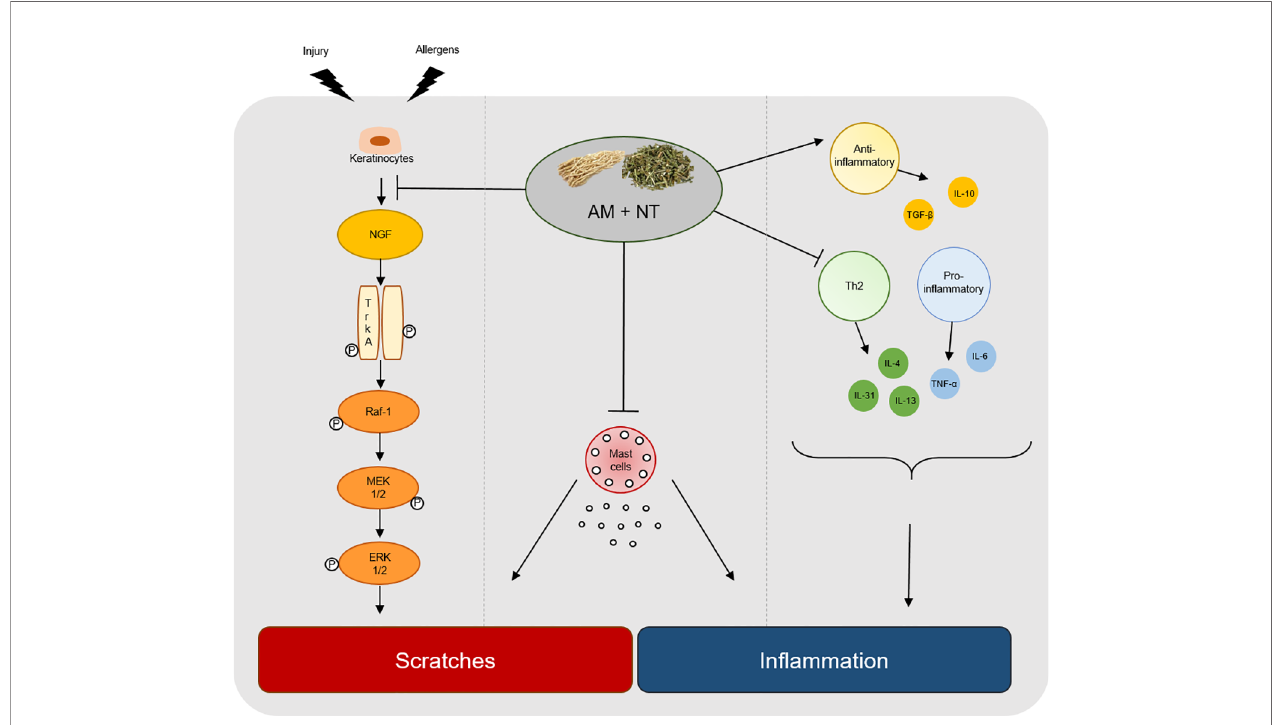
FIGURE 6 | Graphical summary of key process by a mixture of AM and NT, Derma-H, in ACD. Derma-H, a mixture of AM and NT, improved scratches by inhibiting the release of NGF-TrkA signaling and decreasing the number of mast cells. In addition, pro-in fl ammatory, Th2-speci fi c cytokines and anti-in fl ammatory cytokines were effectively regulated by Derma-H. Consequently, Derma-H has ameliorative effects on